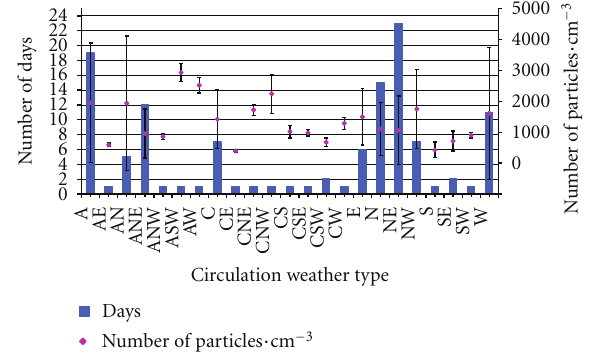
Figure 4: Number of particles registered and standard deviation for each Circulation Weather Type in 121 days in the months of June, July, August and September, in accordance with the days with each particular weather type.